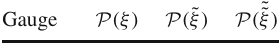
Table 2 Noether charges in the e-gauge for different choices of the vector field